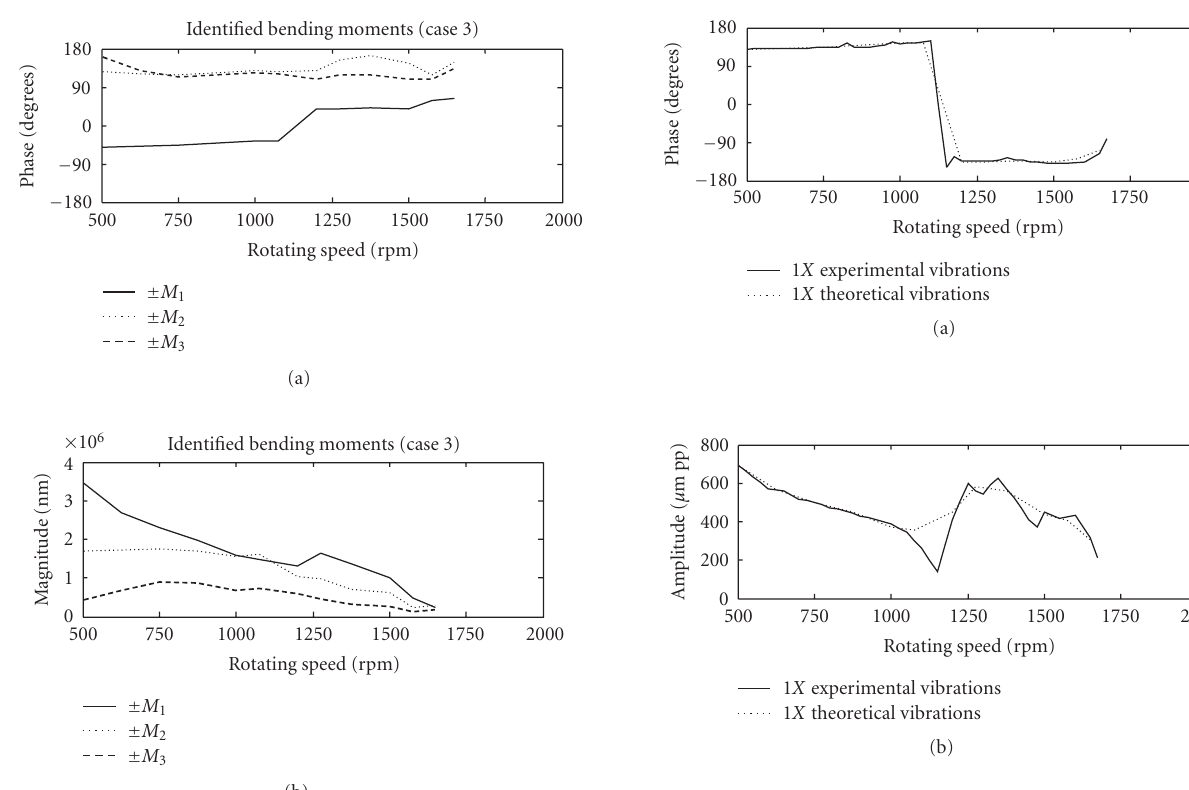
Figure 10: Bode plot of the 1X vibrations caused by the rubs during the coastdown. Comparison between the 1X additional vibrations measured at bearing no. 1 and the numerical results obtained using the identified bending